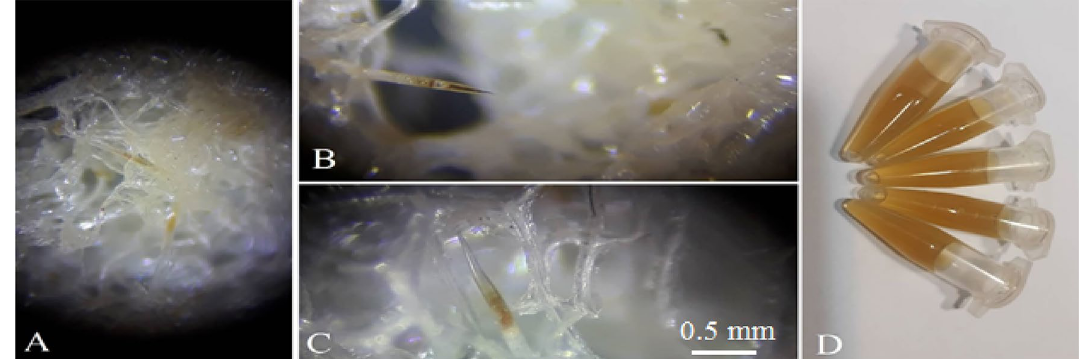
Figure 9. Injectable fluid fixed in needles penetrated into the studied surface with dark yellow color ( A – C ) and venom extract collected from a nettle garden ( D ).